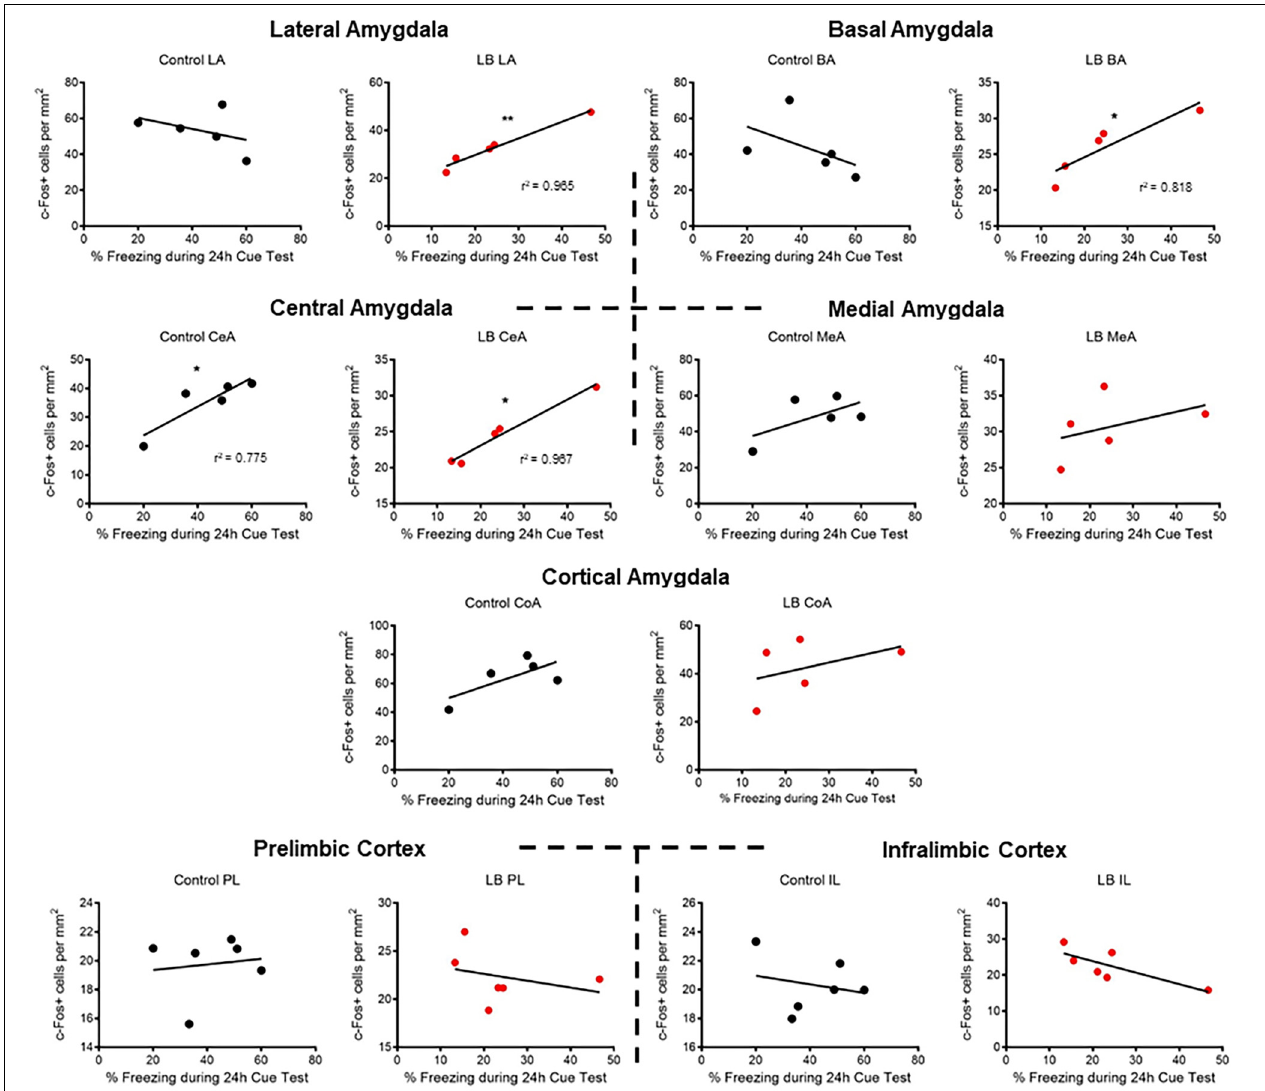
FIGURE 5 | Correlations between cued threat response and ROI activation during adolescence. Correlations were computed between time spent freezing to CS and c-Fos levels for control-reared and maltreated (LB) pups. Pearson’s r values statistically different from 0 are. ∗ p < 0.05, ∗∗ p <